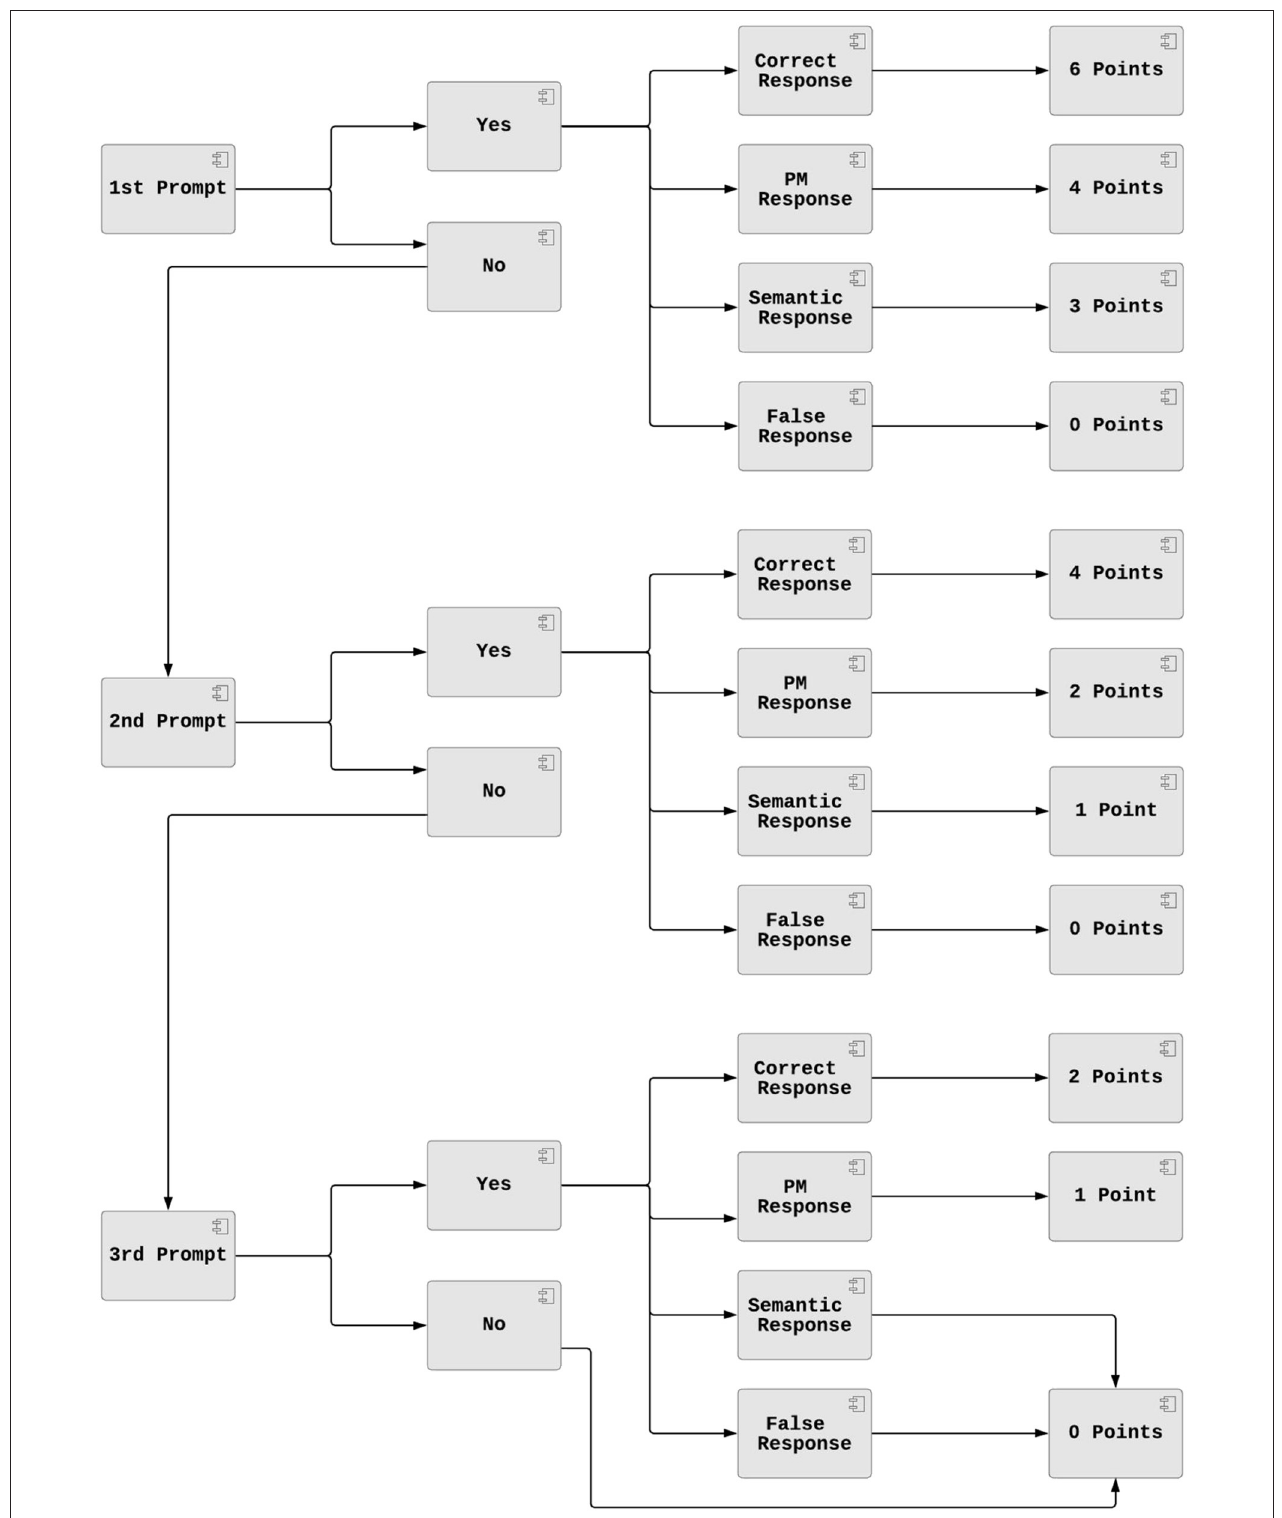
FIGURE 5 | Prospective memory: positive scoring